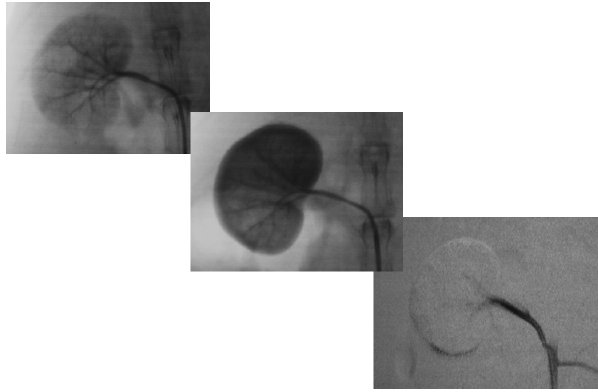
Figure 1 - Renal angiography - Arterial stage and parenchymal before and after embolization